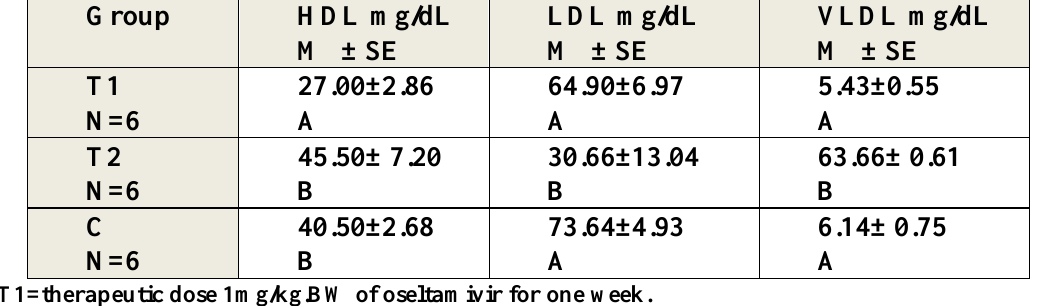
Table(5):- The serum HDL (mg/dL) , LDL (mg/dL) and VLDL (mg/dL) of rats dosed orally therapeutic dose 1mg/kg.BW of oseltamivir for different experimental